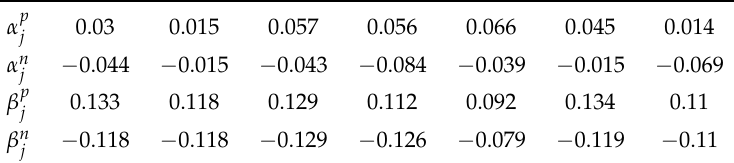
Table 13. Bipolar fuzzy positive and negative ideal solutions.